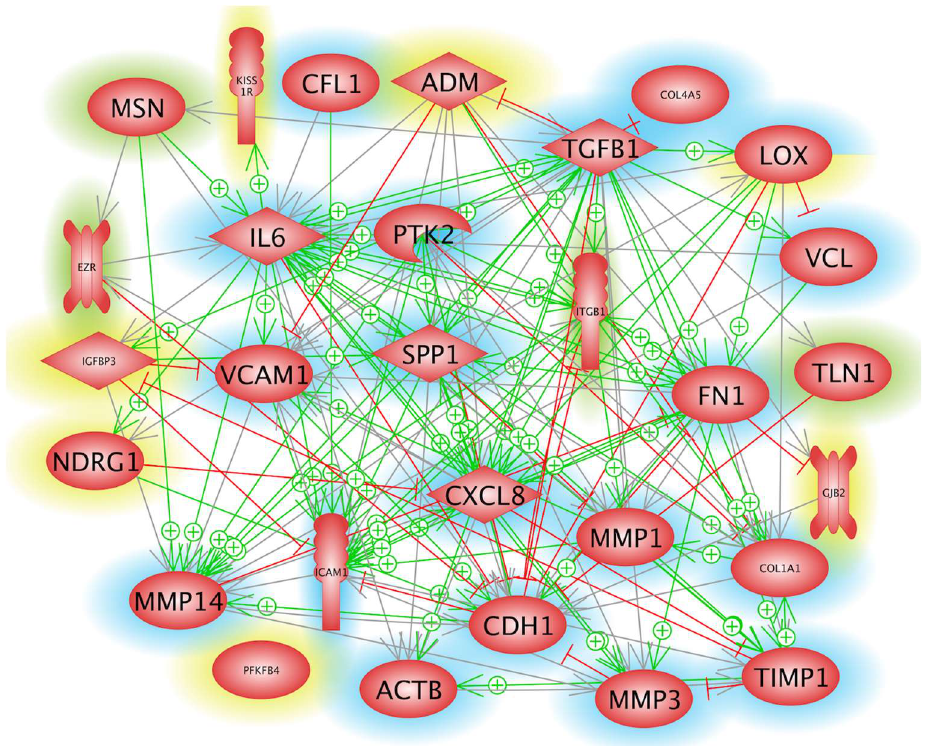
Figure 1. Network of interaction and mutual influence of the identified entities on a gene expression level. The genes, whose icons are marked with a green or blue rim have been found in recent studies referenced or mentioned in the preceding paper [20], respectively. The genes displayed with yellow icons attracted our attention when the two µ g- samples were investigated by gene array analysis, although the result lacked significance due to the fact of only two samples being available per experiments. Green arrows with a plus sign indicate expression or enhanced expression of a gene to which an arrow points to and red lines with a terminal crossbar show suppression or reduced expression of the gene near the crossbar. Grey arrows point to interaction with unknown effects as of now.